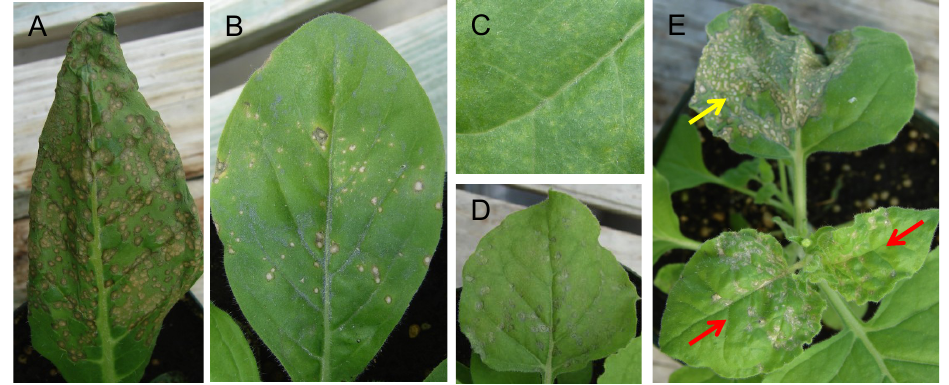
Figure 2. Response of Nicotiana species to TNVD H virion inoculation. ( A ) N. quadrivalvis at 3 dpi. ( B ) N. forgetiana TW50 at 5 dpi. ( C ) N. otophora at 3 dpi. ( D ) N. benthamiana at 5 dpi. (E) N. benthamiana at 9 dpi. The red arrows indicate N. benthamiana leaves exhibiting systemic symptoms, whereas the yellow arrow indicates lesions in an inoculated leaf.